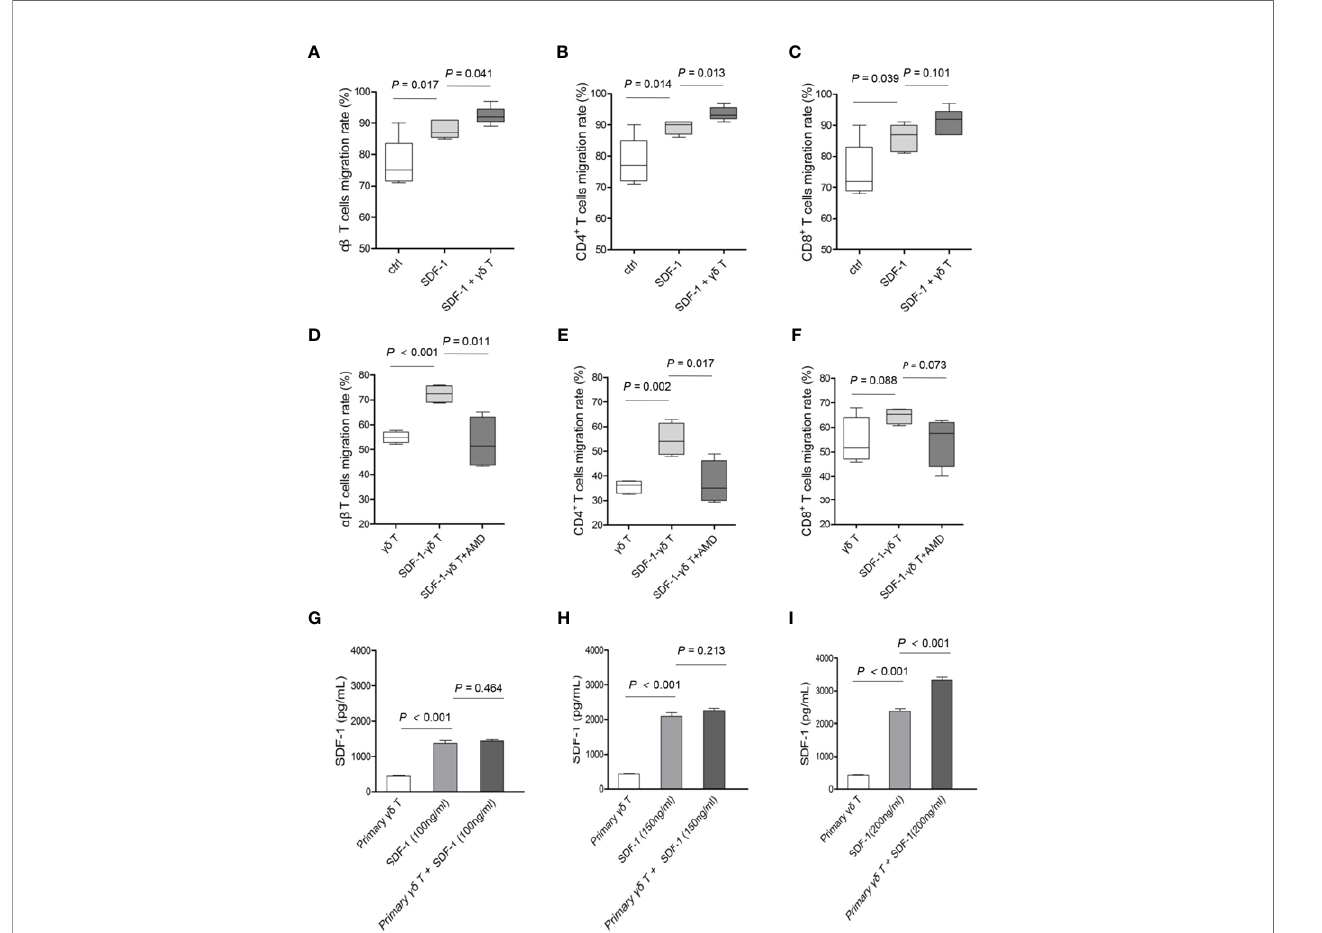
FIGURE 4 | The impact of gd T cells and SDF-1-CXCR4 axis on the migrations of CD4 and CD8 T cells. The migratory abilities of ab T cells (A) , CD4 T cells (B) and CD8 T cells (C) towards gd T cells were examined, with or without SDF-1. The migratory abilities of ab T cells (D) , CD4 T cells (E) and CD8 T cells (F) towards SDF- 1-driven gd T cells were examined, with or without an antagonist (AMD3100) of CXCR4 signaling. The supernatants of gd T cells pretreated with indicated concentrations of SDF-1 for 24 h were collected for ELISA test (G – I). Data are expressed as the mean ± SD of triplicate cultures. P values are shown on the